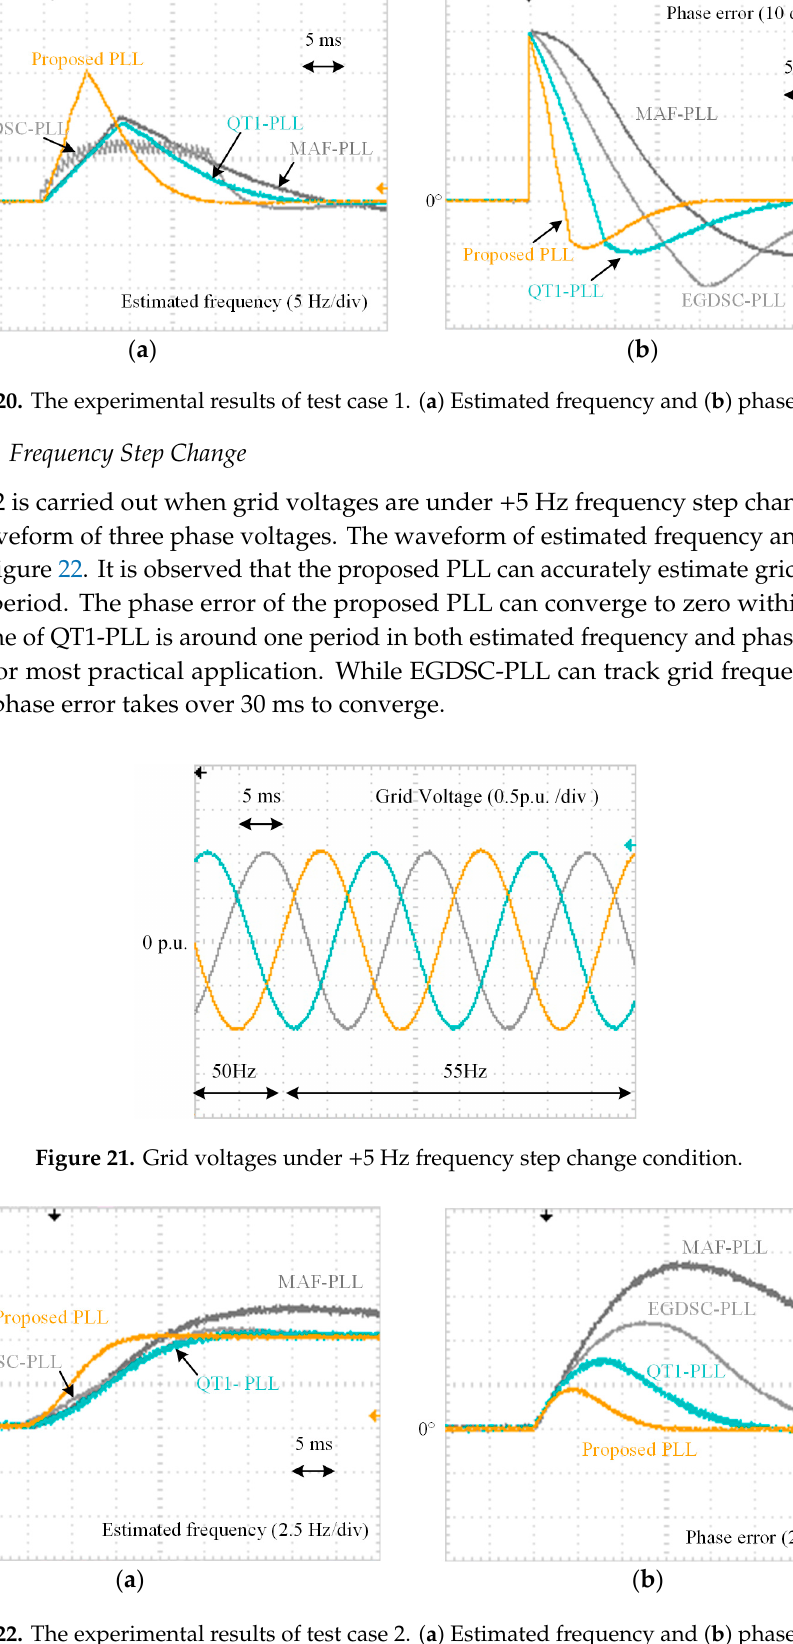
Figure 19. Grid voltages under +40° phase jump condition.